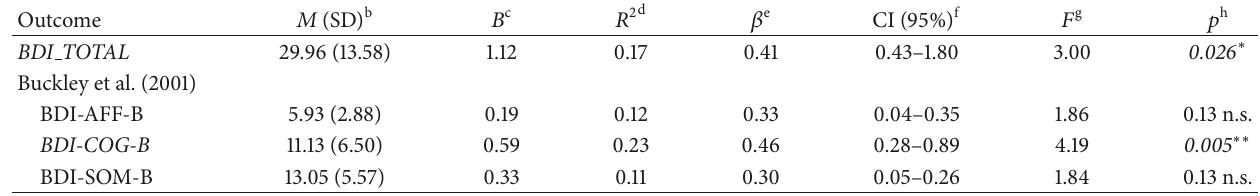
Table 3: Hierarchical regressions a of the MRS-quantity on different facets of self-reported depressiveness (BDI-II).